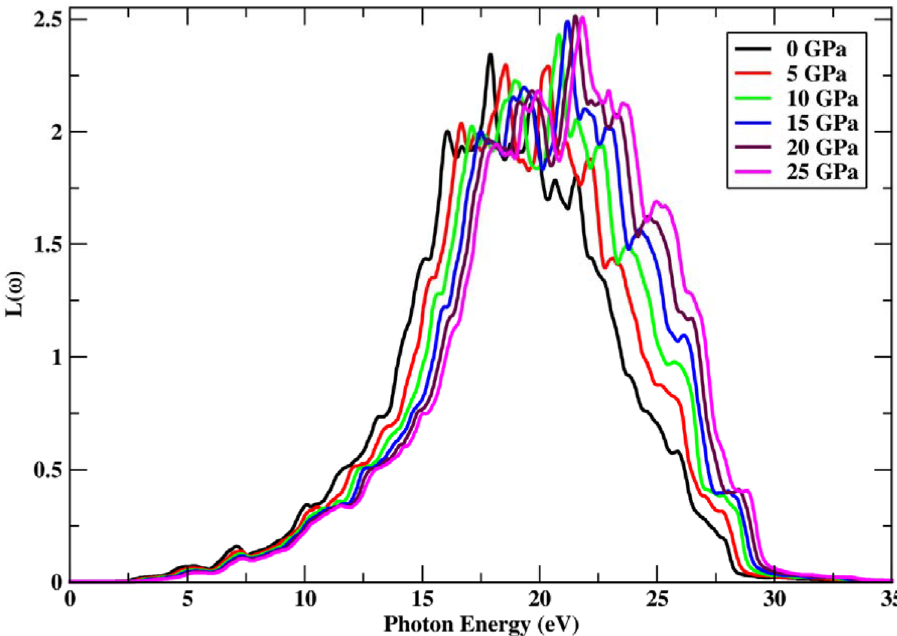
Figure 9. Chnage in energy loss function under the effect of